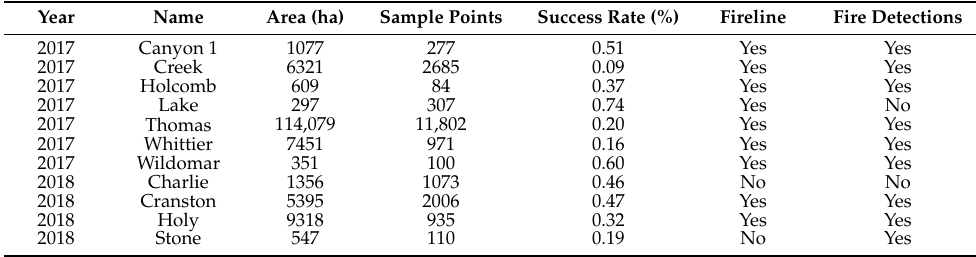
Table 1. Characteristics of the large wildfires in our analysis of fuel break effectiveness, including fire year, name, area, the number of point samples of fuel break–wildfire interactions, fuel break success rate (% of point samples that held), availability of fireline data (see suppression section), and availability of fire detection data (see fire behavior